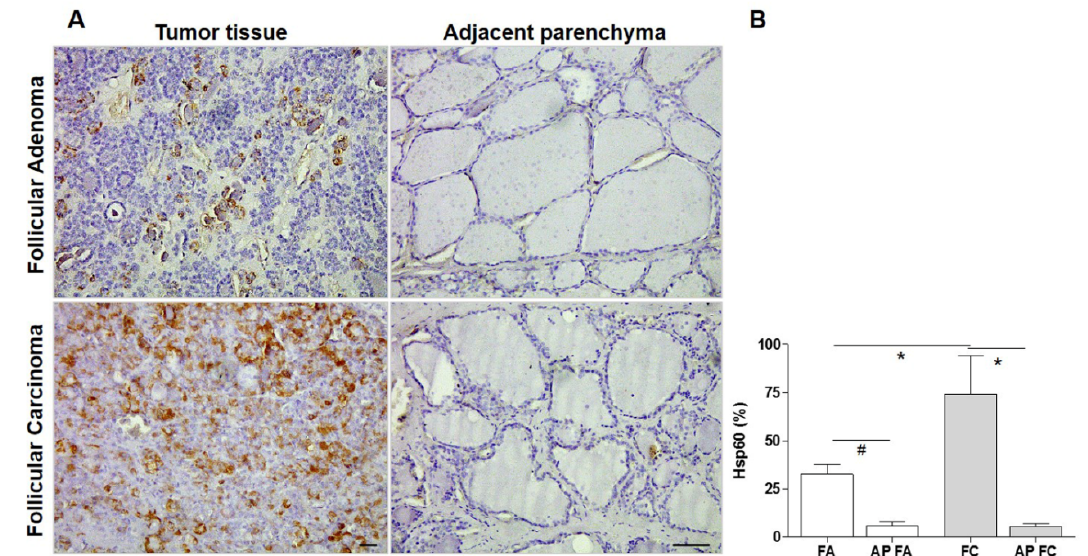
Figure 2. Hsp60 Immunohistochemistry. ( A ) Representative images of immunohistochemical results for Hsp60. Magnification 200X; scale bar 100 μm. ( B ) The histogram shows statistical results for the immunohistochemical evaluation for Hsp60 in follicular adenoma (FA), adjacent parenchyma of follicular adenoma (AP FA), follicular carcinoma (FC) and adjacent parenchyma of follicular carcinoma (AP FC). Data are presented as the mean +SD. * p ≤ 0.0001, # p ≤ 0.01.